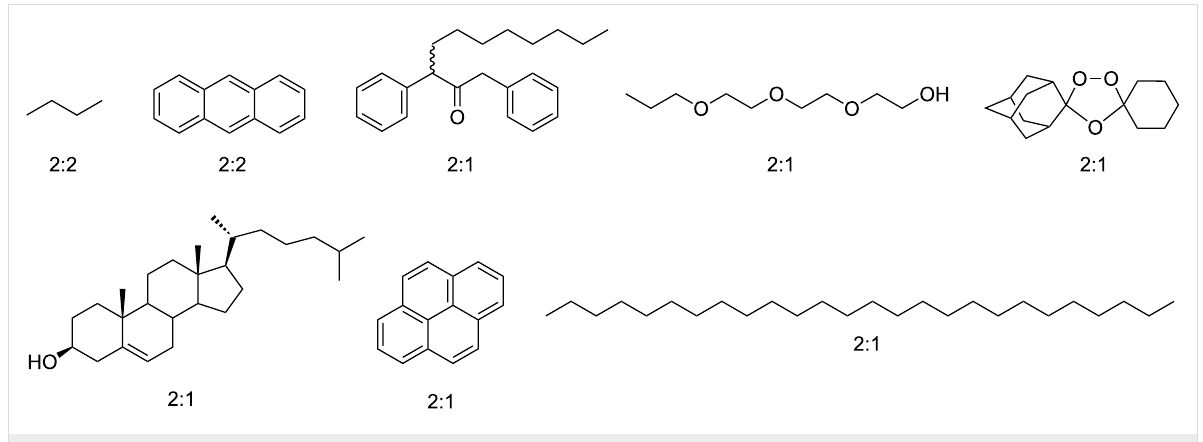
Figure 7: Representative guests for the capsular complexes formed by octa-acid (stoichiometry shown in parenthesis).